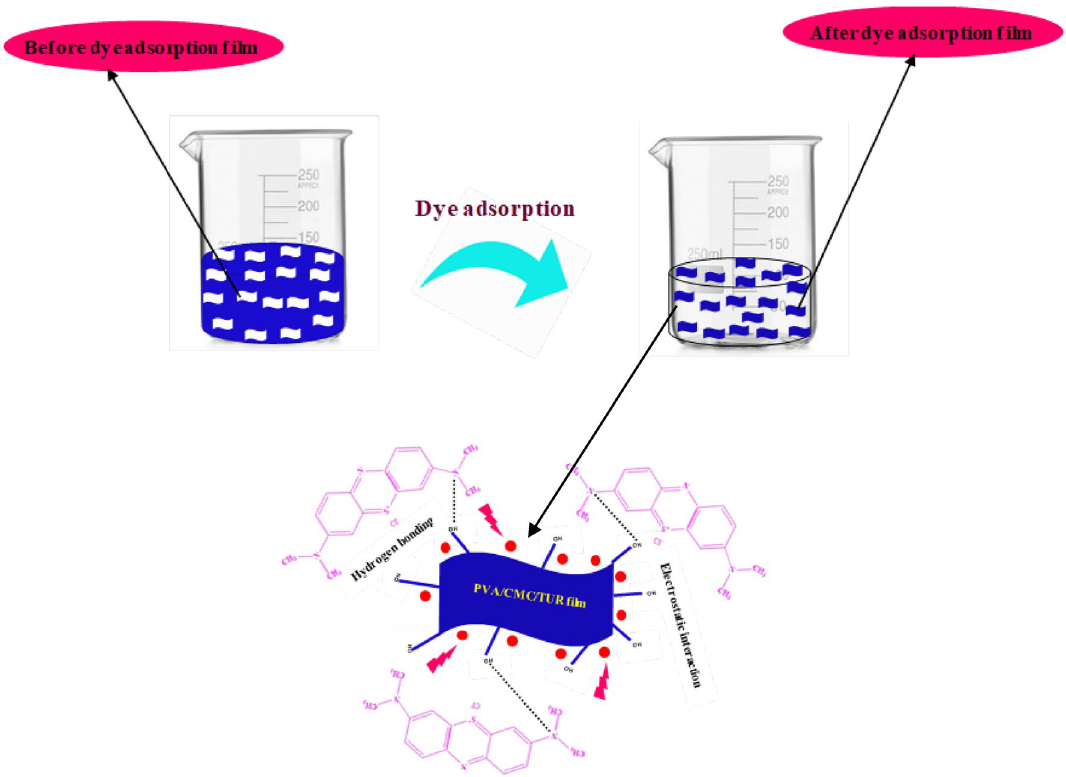
Figure 14. MB dye molecules interact with the PVA/CMC/TUR